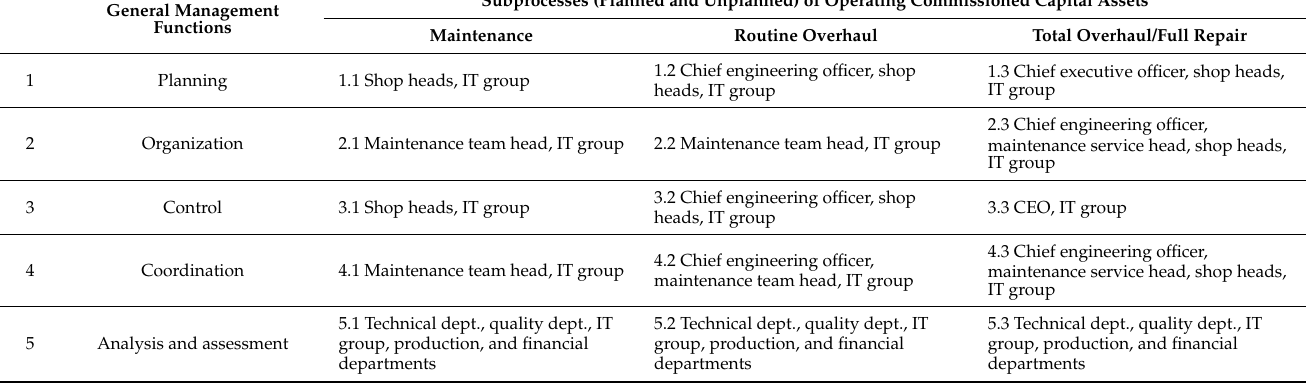
Table 4. Managing operation of the commissioned assets for a production company using previously developed BIM